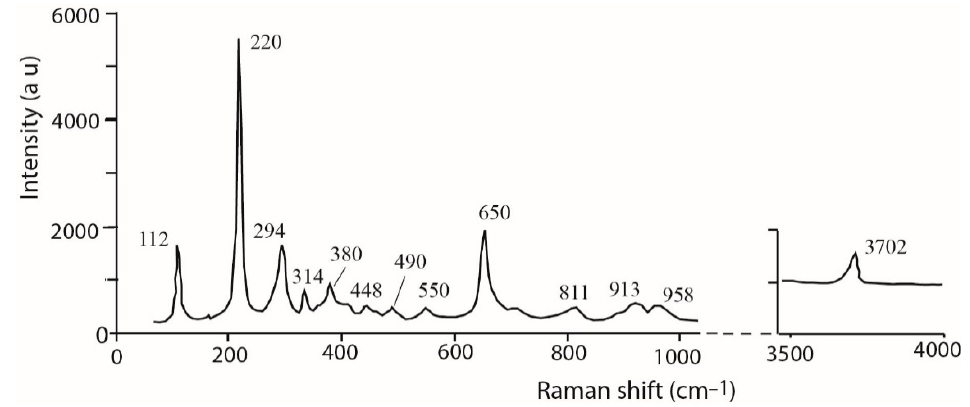
Figure 3. Raman spectra for the Luc Yen preiswerkite specimen.